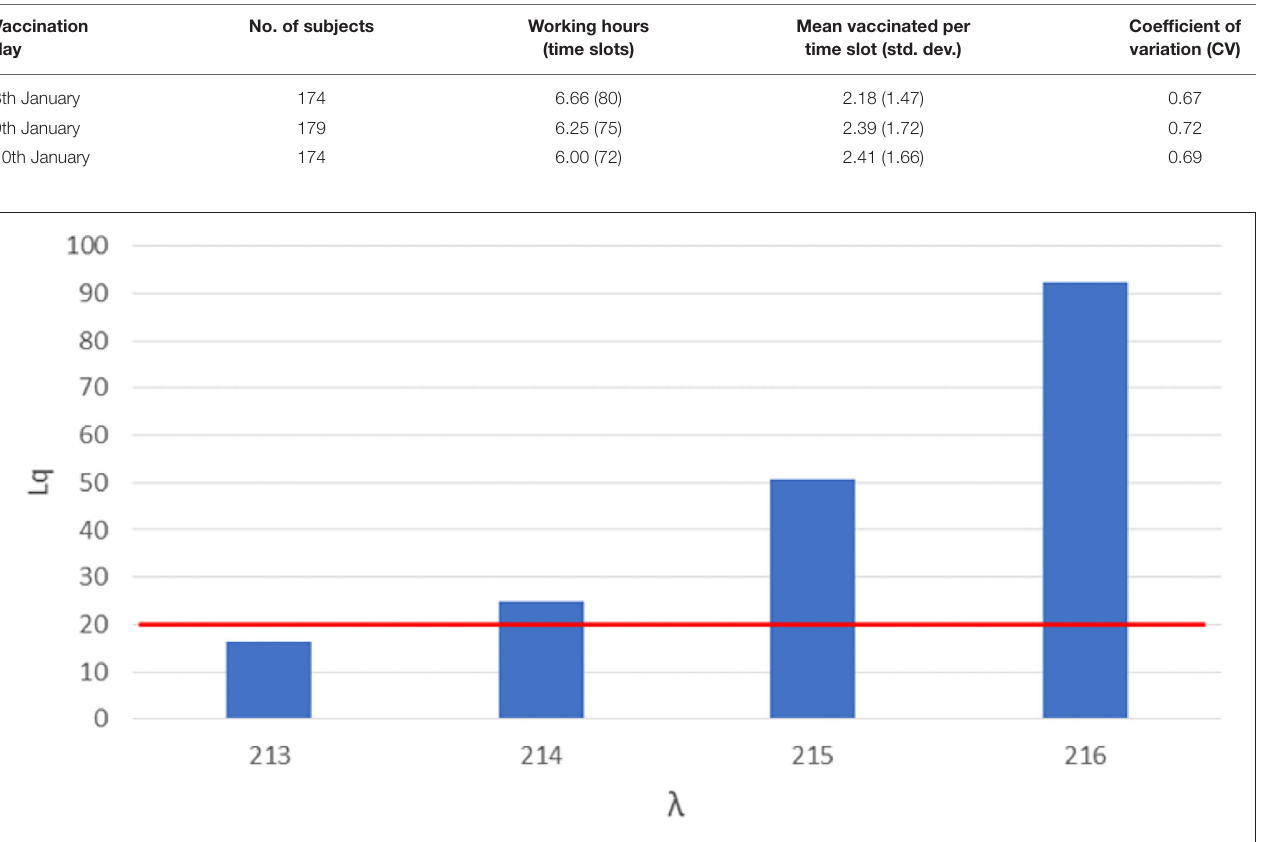
FIGURE 1 | Number of queueing subjects (Lq) by one-unit increases in arrival rates ( λ ) in original setting. Maximum queue length evidenced in red